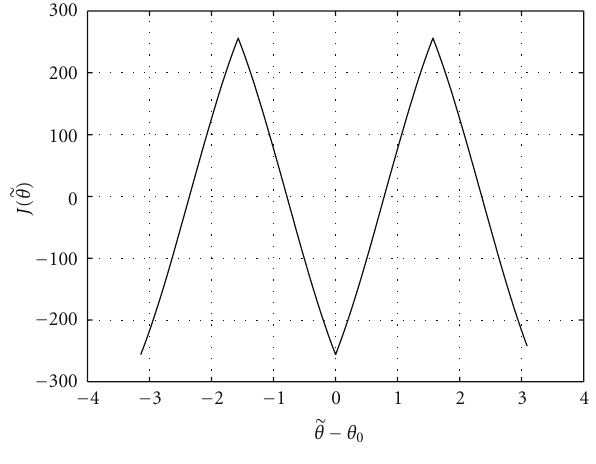
Figure 2: J ( (cid:2) θ ) = L R ( (cid:2) θ ) − L I ( (cid:2) θ ) versus the phase o ff set estimation error ( (cid:2) θ − θ 0